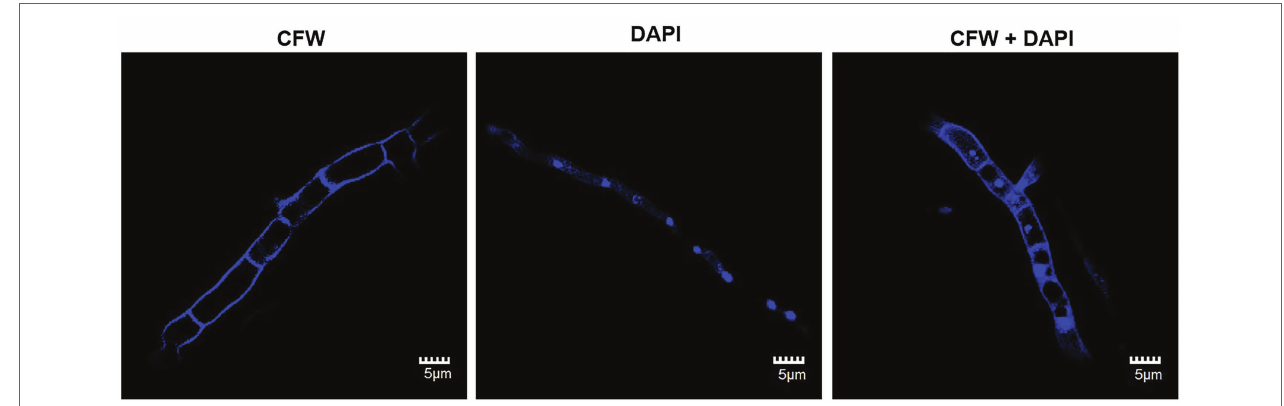
FIGURE 1 | Fluorescence microscopy images of the stained vegetative hyphae of C. empetri MEFC009. CFW: CFW-stained image of hyphae. DAPI: DAPI-stained image of hyphae. CFW + DAPI: CFW and DAPI-stained image of hyphae. All scale bars represent 5 μ